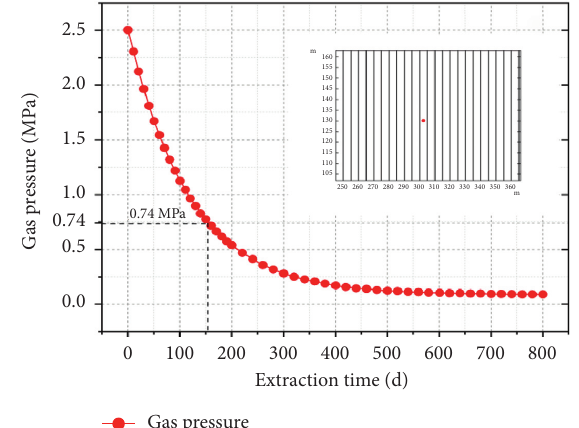
Figure 5: Gas pressure change over time at the monitoring